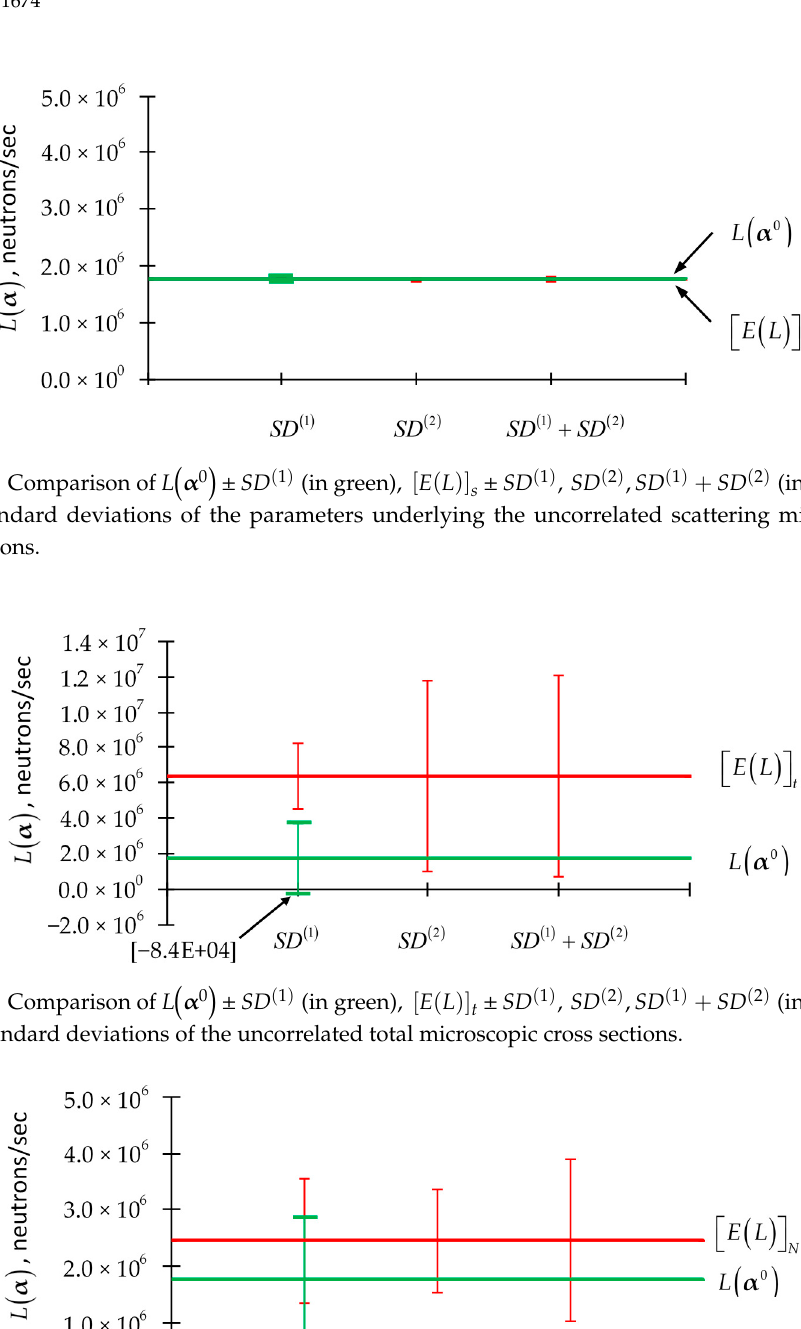
Figure 15. Comparison of